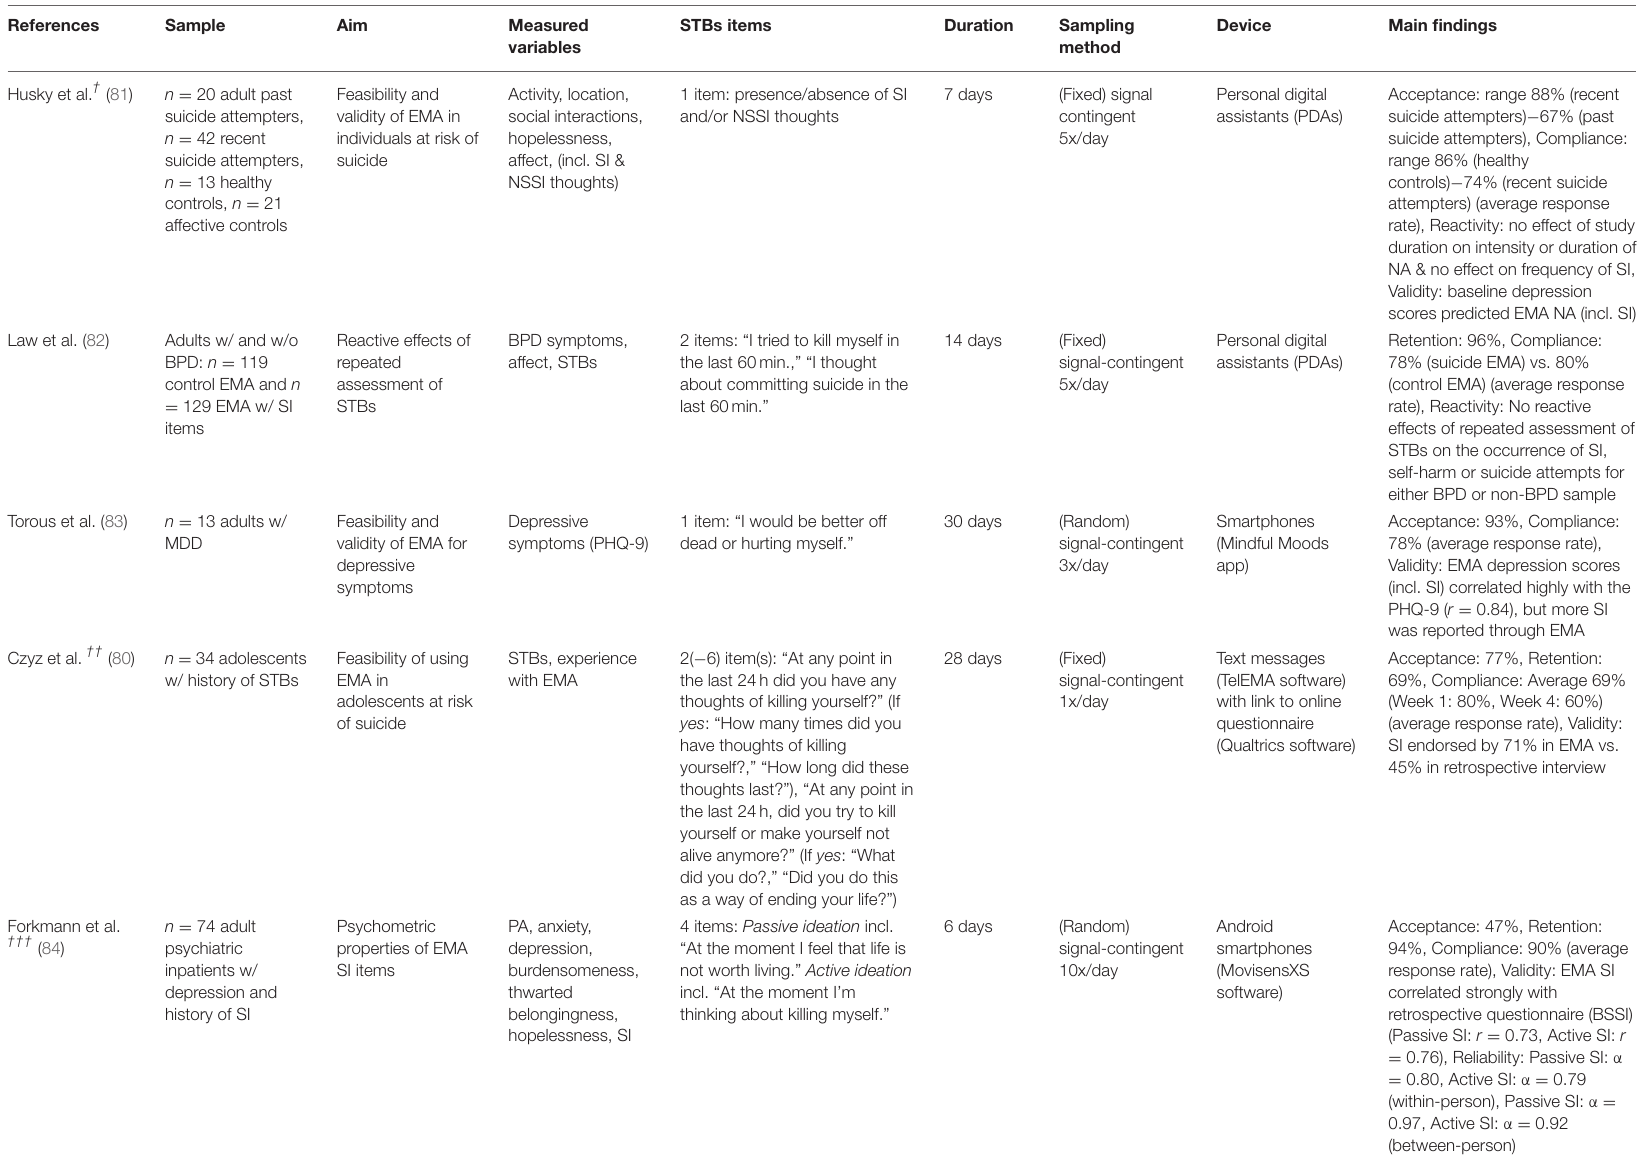
TABLE 2 | Overview of manuscripts assessing the feasibility and validity of using EMA to assess suicidal thoughts and behaviors